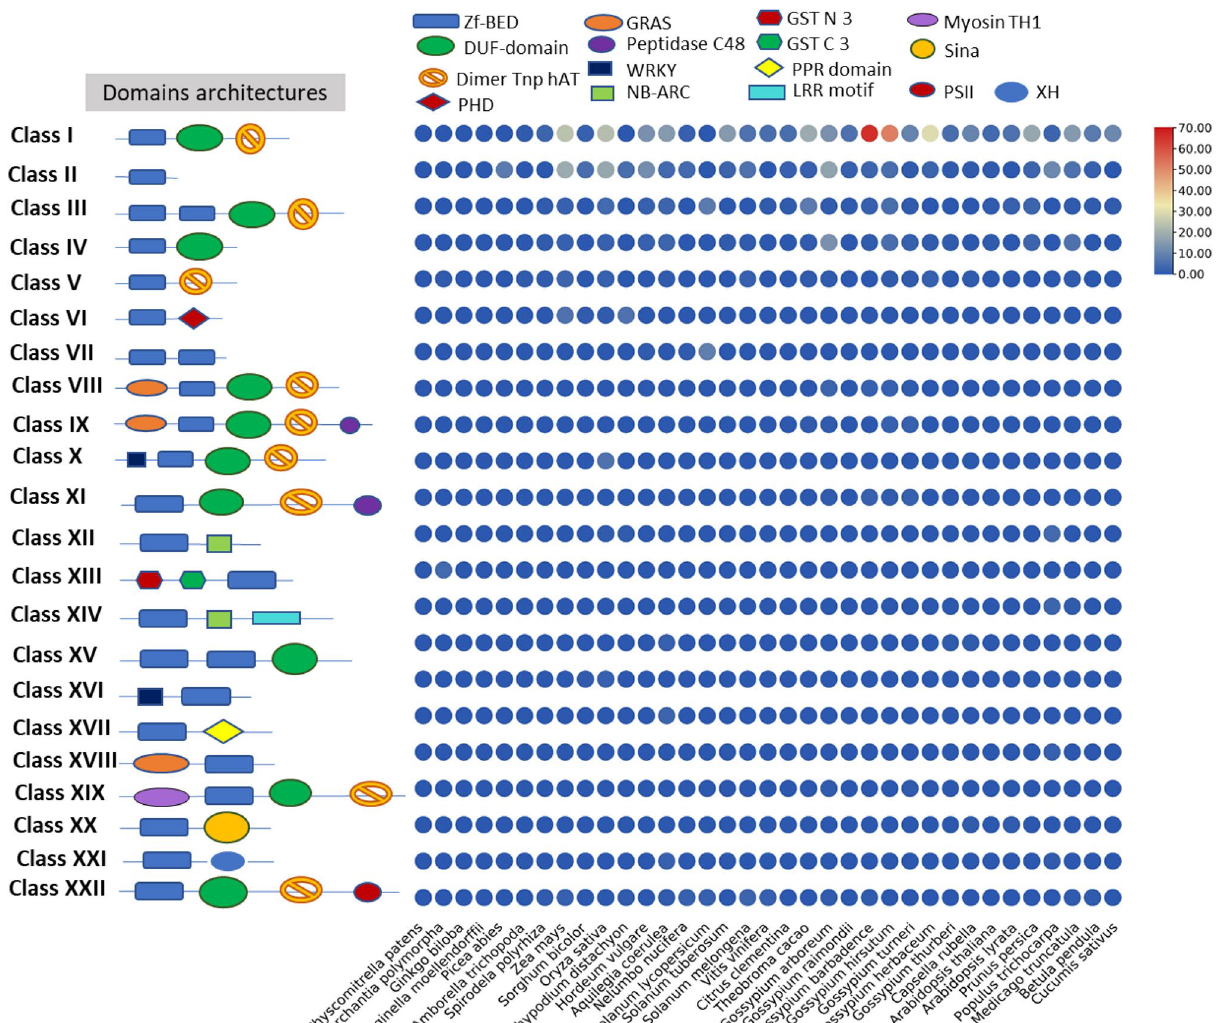
Figure 2. Classes of Zf-BED proteins based on conserved domains and their comparison among land